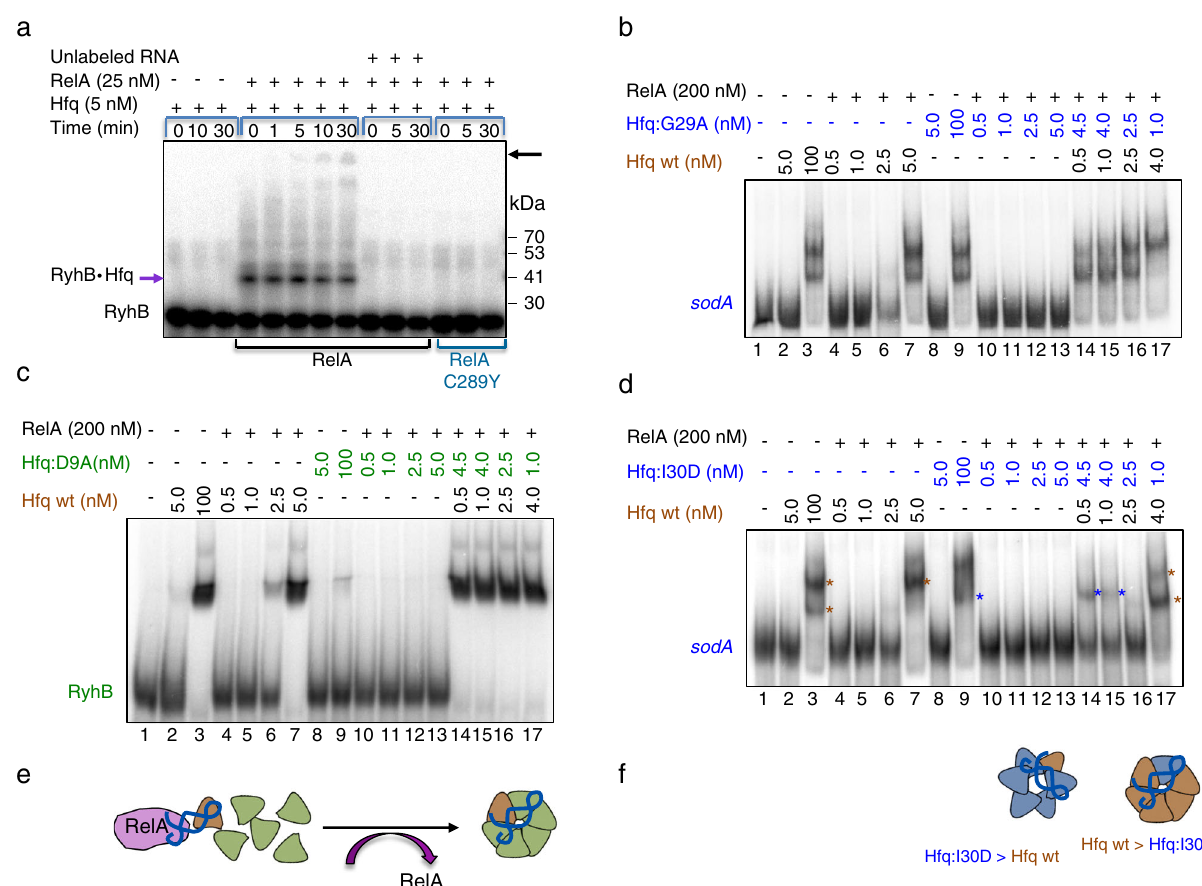
Fig. 5 RelA stabilizes the binding of RNA to Hfq monomer and enables further assembly. a RelA facilitates RyhB binding to Hfq monomers. Reaction mixtures of Hfq incubated for 10 min at 22 °C with labeled RyhB (1 nM; 90 nt) without or with RelA or RelA:C289Y were UV crosslinked (zero time point) followed by protein crosslinking with 0.2% glutaraldehyde. The crosslinking was stopped with 200 mM of fresh glycine and the products analyzed in 4 – 20% MOPS gradient gel. Unlabeled competitor RNA (100 nM) was added where indicated. The estimated MW of the RNA • Hfq monomer complex (purple arrow on lower left side) is ~40 kDa. Note that the addition of RNA alone to low levels of Hfq (5 nM) does not result in Hfq-RNA stable binding. Also, RelA:C289Y does not enable the binding of RNA to Hfq monomers. In the presence of RelA, as time of crosslinking progressed, higher forms of